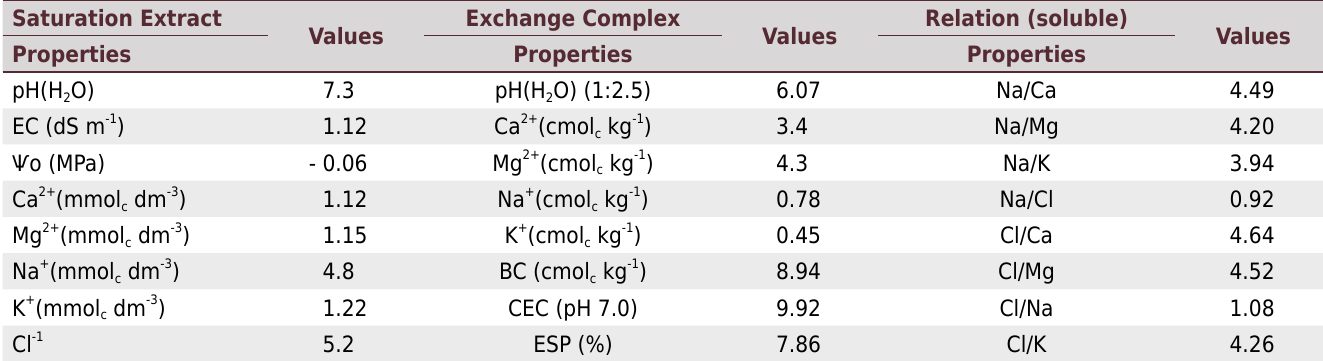
EC: electrical conductivity; Ѱo: osmotic potential; BC: sum of base cations; ESP: exchangeable sodium percentage; CEC: cation exchange capacity. pH in water (1:2.5) and exchangeable Ca, Mg, Na, and K contents, which were extracted with ammonium acetate 1 mol L -1 (Thomas, 1982). A saturation